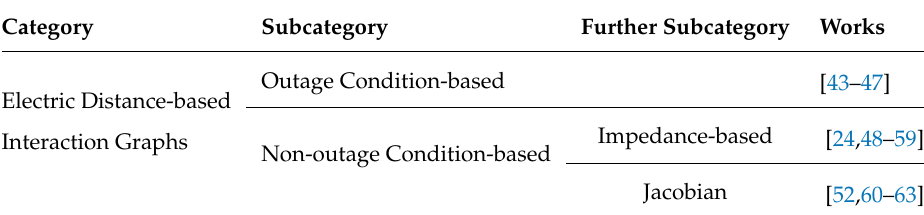
Table 3. Classification of existing studies using the electric distance-based